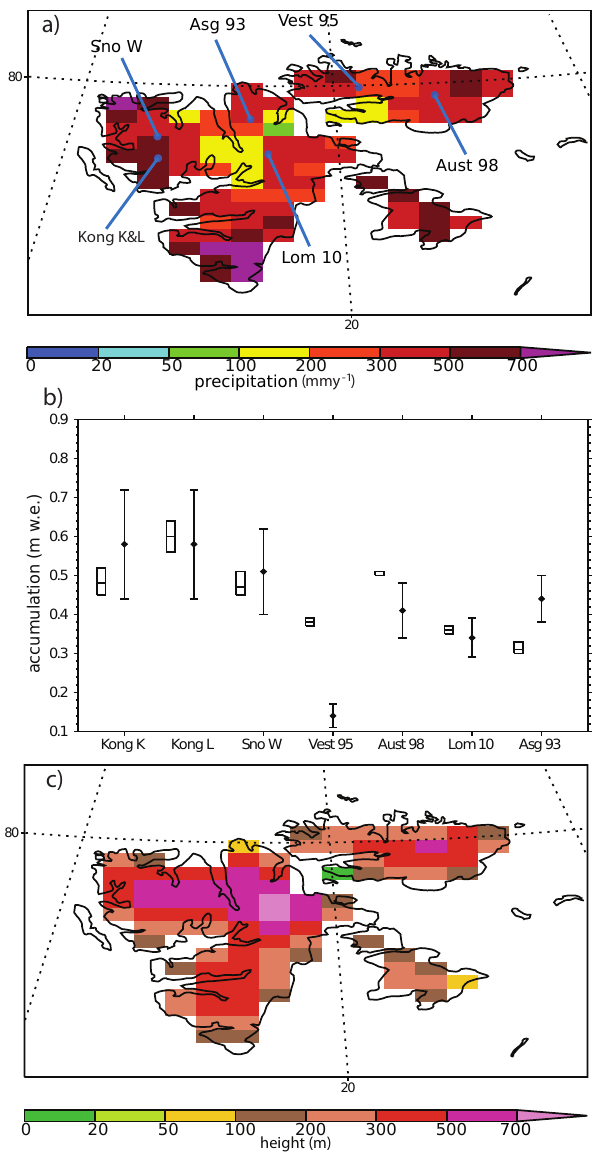
Fig. 5. RCM annual total precipitation and ice core locations (blue), (a) , Ice core net accumulation minimum, mean, maximum (box) and RCM total precipitation ( ± σ , whiskers), (b) , and RCM oro- graphic height, (c)